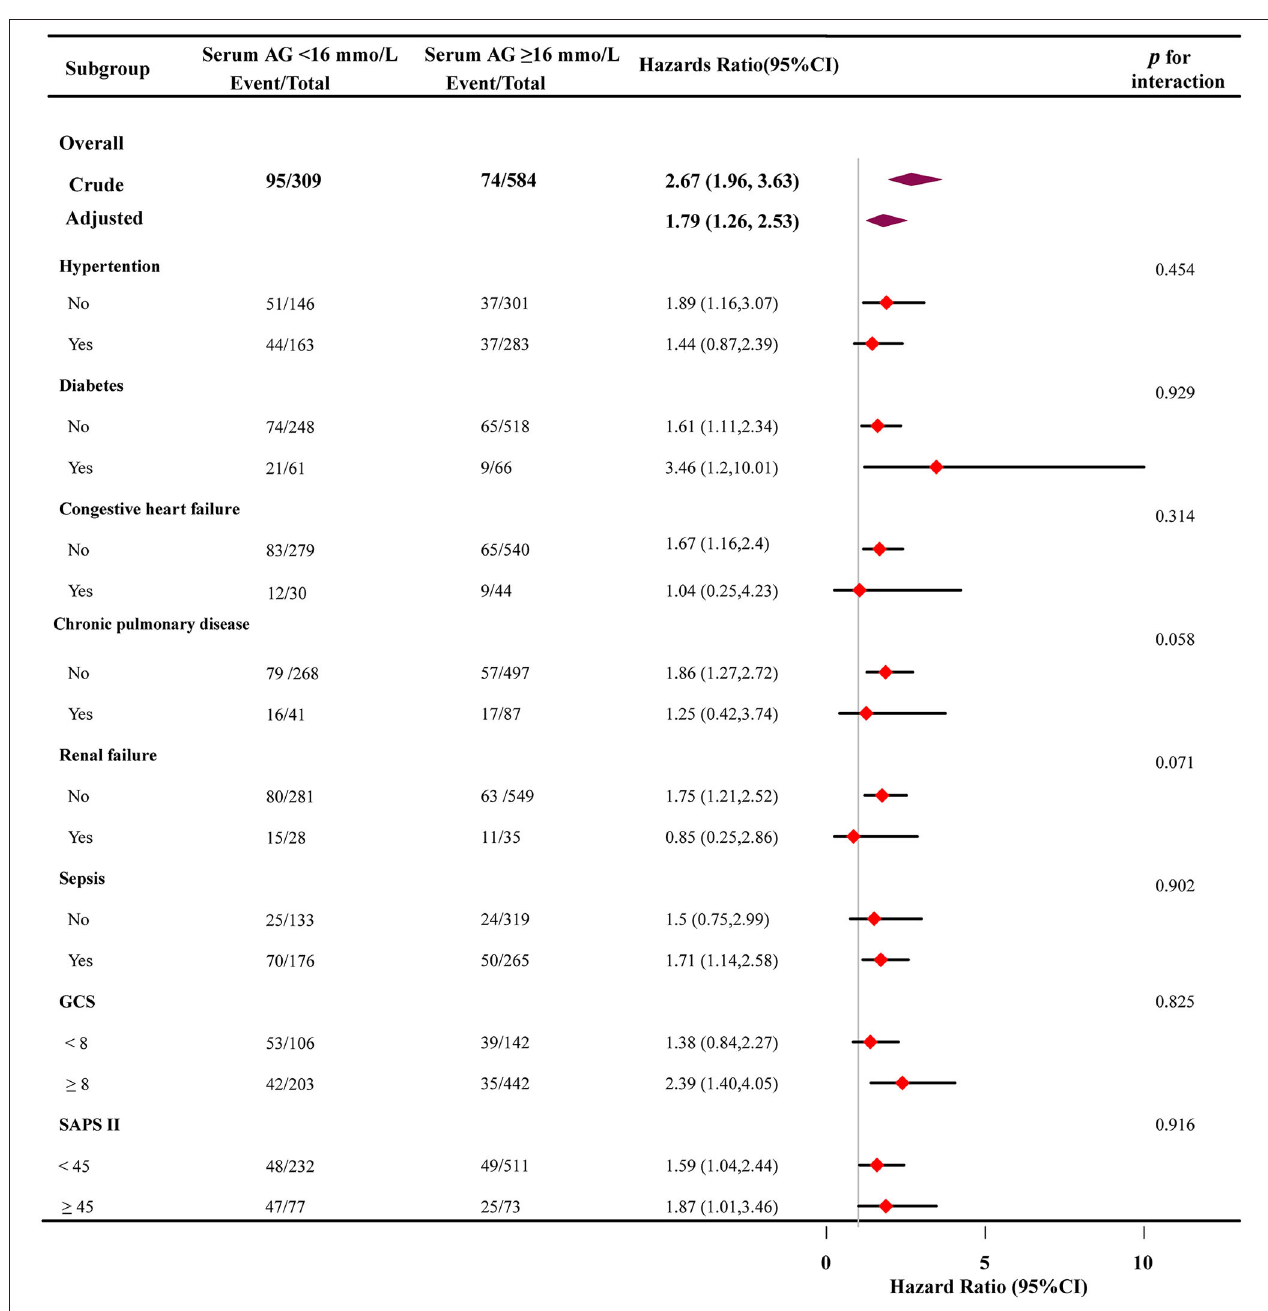
FIGURE 4 | Subgroup analyses of the effect of on hospital all-cause mortality. adjusted for age, sex, and ethnicity, SBP, DBP, respiratory rate, GCS, diabetes, sepsis, renal failure, chronic pulmonary disease, vasopressor, embolization of aneurysm, Clipping of aneurysm, WBC, platelet, hemoglobin, glucose, BUN, creatinine. In each case, the model was not adjusted for the stratification